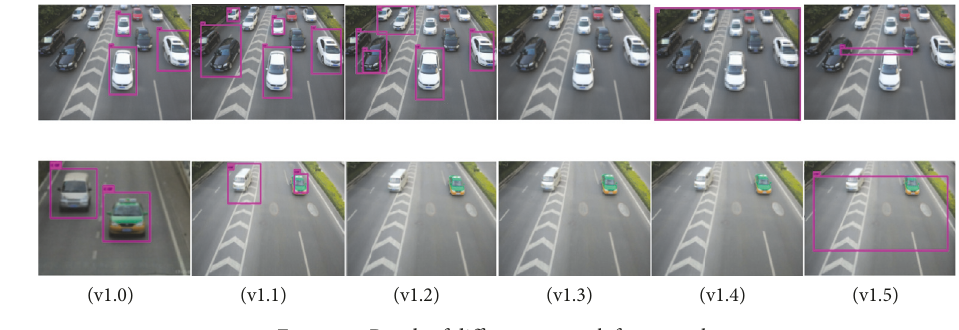
Figure 5: Result of different network framework.